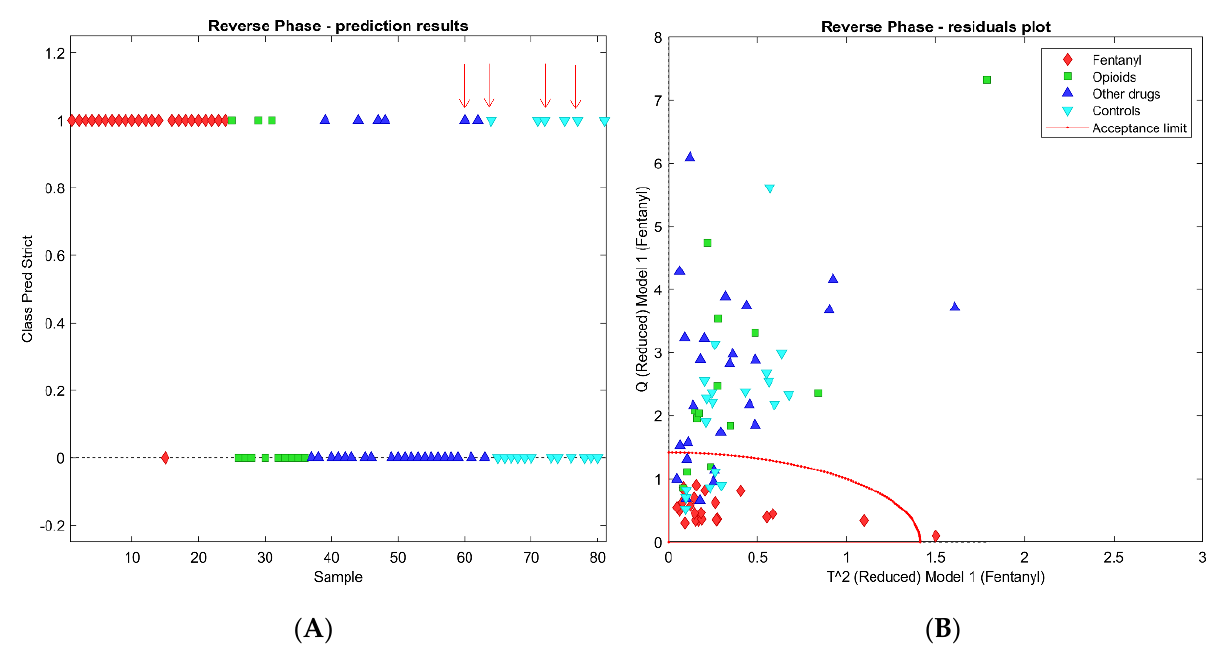
Figure 4. SIMCA models obtained with the RP dataset: ( A ) reports the prediction results and ( B ) the residuals plot. The red arrows indicate the misclassified samples by both the SIMCA models built on RP and HILIC datasets.